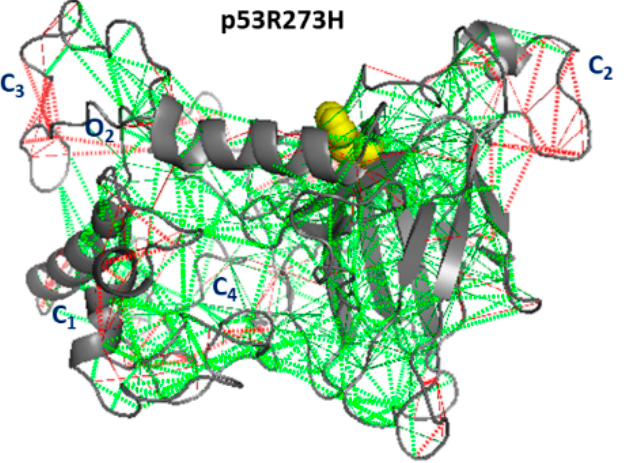
Figure 10. Frustration analysis of p53R273H. The level of frustration is represented by the coloured scale: green represents minimal frustration and red high frustration. The mutated residue (273H, yellow) and the Zn ion are represented as spheres.